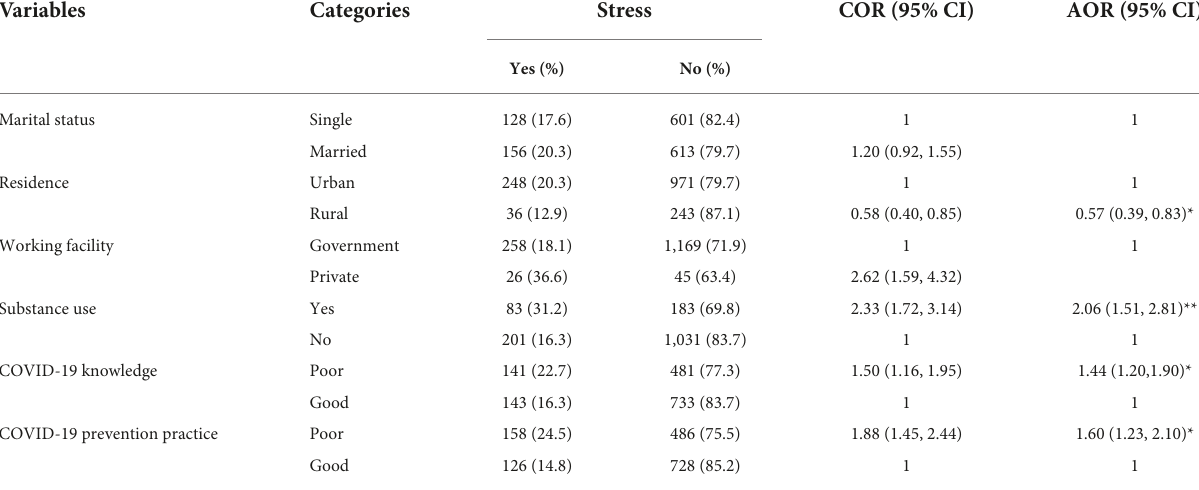
TABLE 4 Bivariable and multivariable logistic regression analysis for factors associated with stress among midwives in Ethiopia in 2020 ( n =